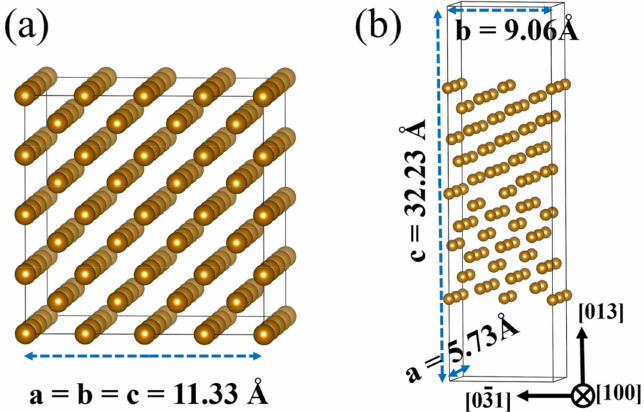
Figure 3. Modelled structure of ( a ) bcc-Fe bulk, ( b ) bcc-Fe Σ 5